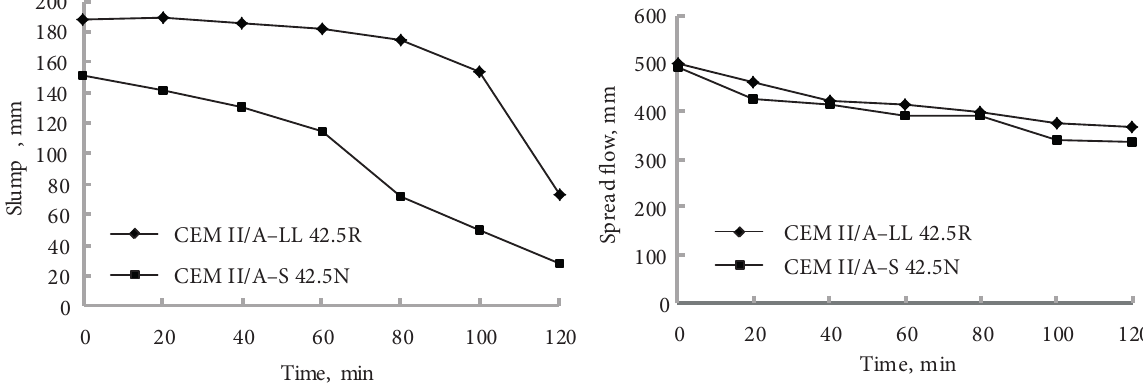
Fig. 4. A concrete mixture with different types of Portland cement and with no dependence of superplasticizer spread flow on time at a temperature of +15